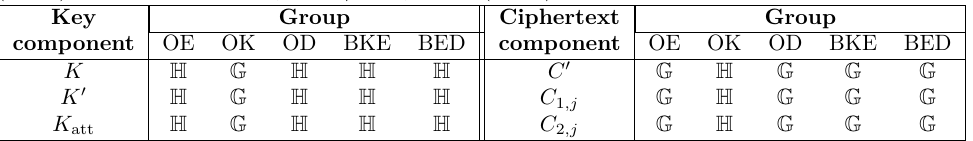
Table 3: The distributions of the key and ciphertext components of Wat11-I over the groups G and H , for each optimization approach, i.e., optimized encryption (OE), optimized key generation (OK), optimized decryption (OD), balanced key generation/encryption (BKE) and balanced encryption/decryption